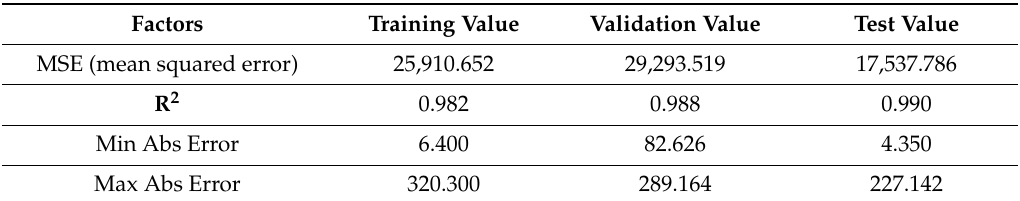
Table 9. The results of the ANN model.